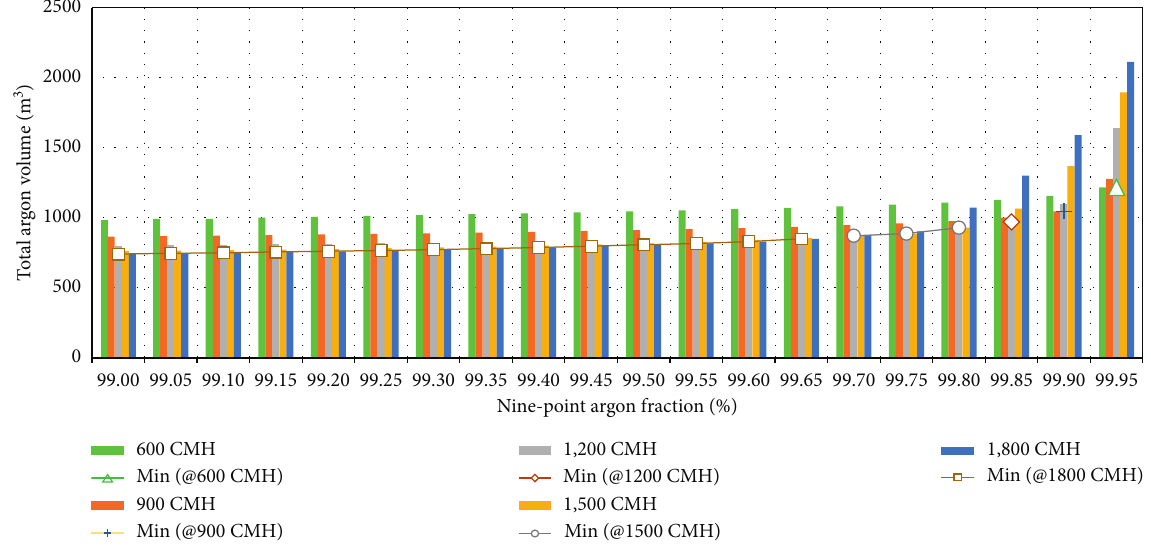
Figure 12: Suggestion of flow rate combination for efficient purging, appropriate combination of purging flow rate for argon inerting of the target facility to minimize the total argon volume (“Min(@(x) CMH)” signifies the flow rate “ x ” that requires minimized total argon volume among the considered five flow rates to achieve the associated saturation level).